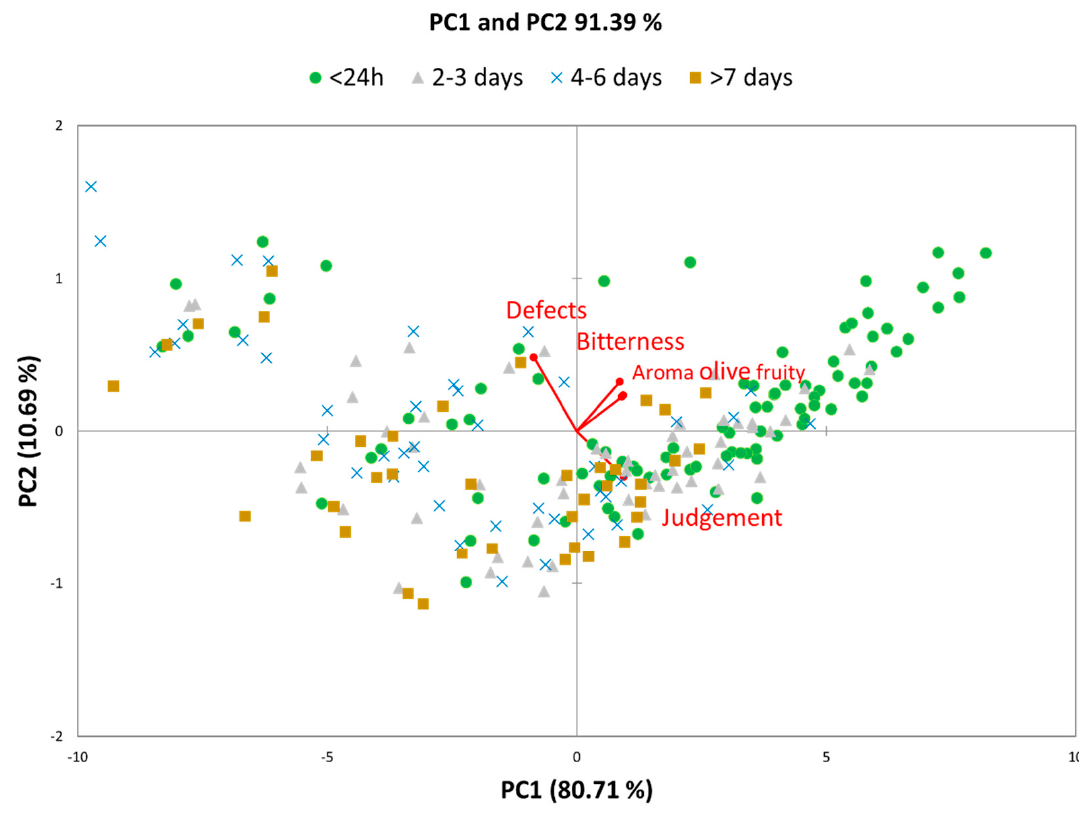
Figure 1. Principal component analysis (PCA) plot of sensory data.